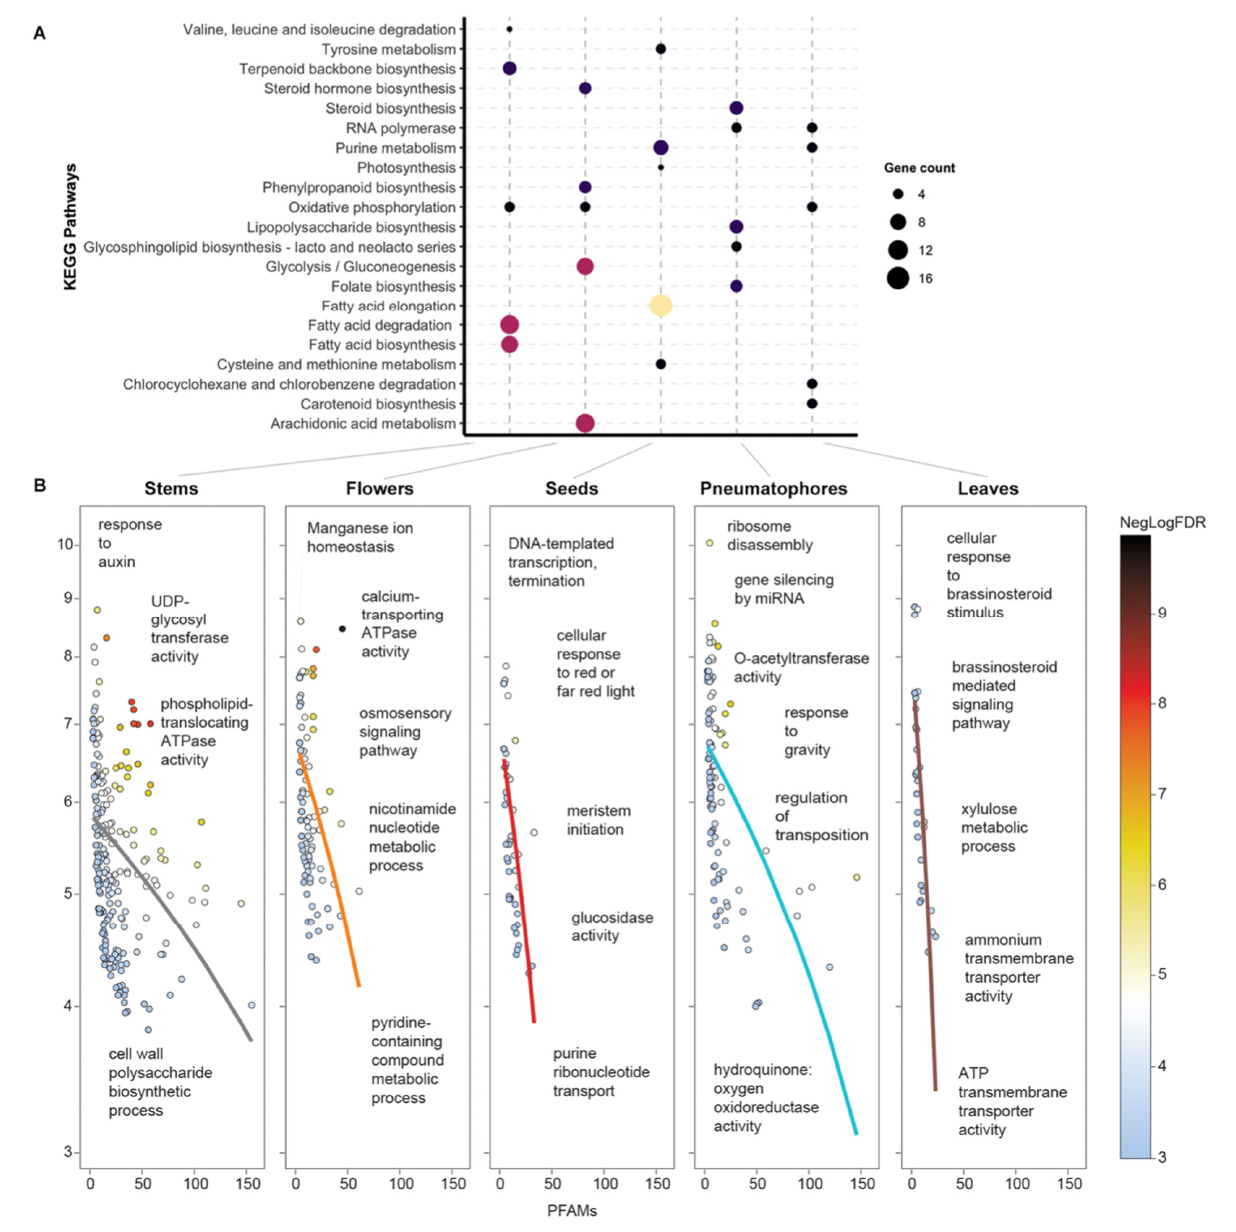
Figure 3. Tissue-specific KEGG pathways and GO term enrichment in A. marina . ( A ) Top five KEGG pathways with regard to uniquely expressed transcripts for each tissue. The y-axis represents the pathway name. The size of the bubble indicates the number of transcripts in the KEGG pathway. The color represents the gene count, with yellow representing a higher value and black representing a lower value. Transcripts expressed at > 10 TPM (see Table S1) in each tissue were used to retrieve the KEGG orthologs. ( B ) Domain-centric gene ontology (dcGO; [74]) enrichment in uniquely expressed transcripts in the Red Sea cultivar.